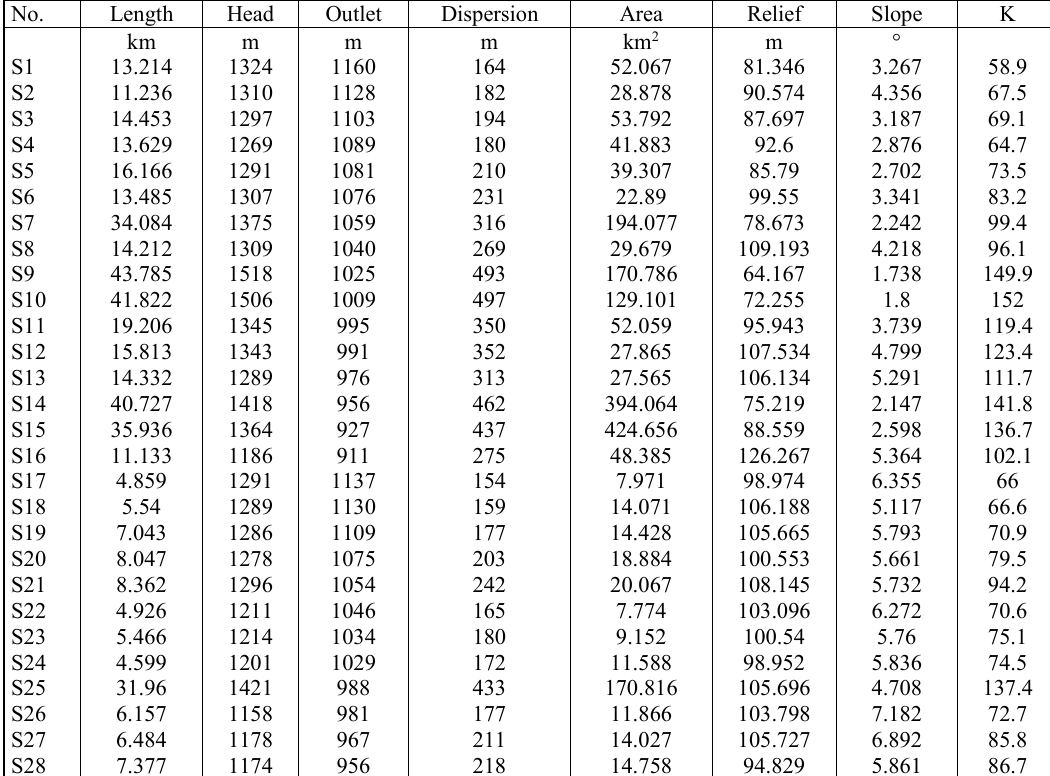
Table 1. Parameters of